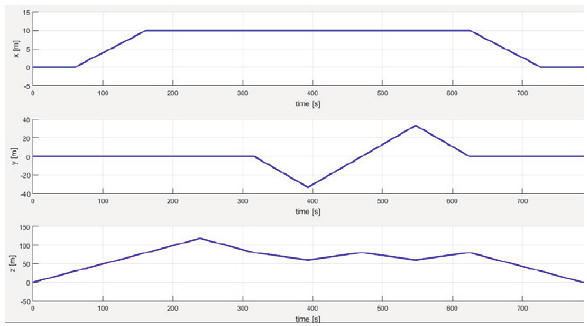
Figure 7. Position oscillations with respect to time